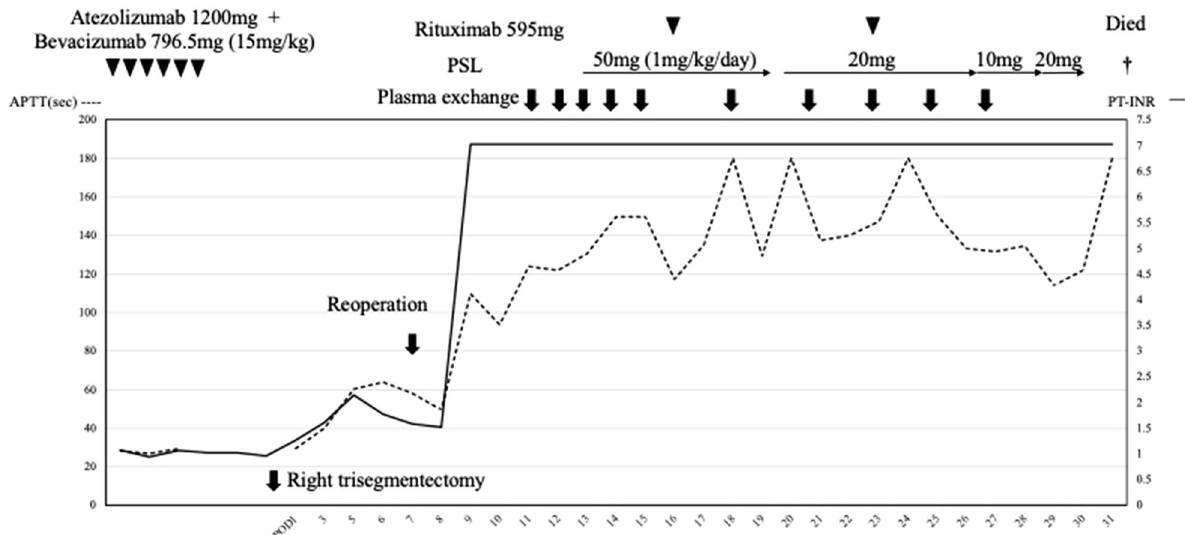
Fig. 3 Perioperative course. The solid line indicates the change in prothrombin time, while the dotted line indicates change in the activated partial thromboplastin time. Before surgery, 6 courses of atezolizumab (1200 mg) plus bevacizumab (796.5 mg [15 mg/kg]) were administered with 21-day intervals between courses. Right trisegmentectomy of the liver was performed 8 days after completion of atezolizumab and bevacizumab administration. POD postoperative